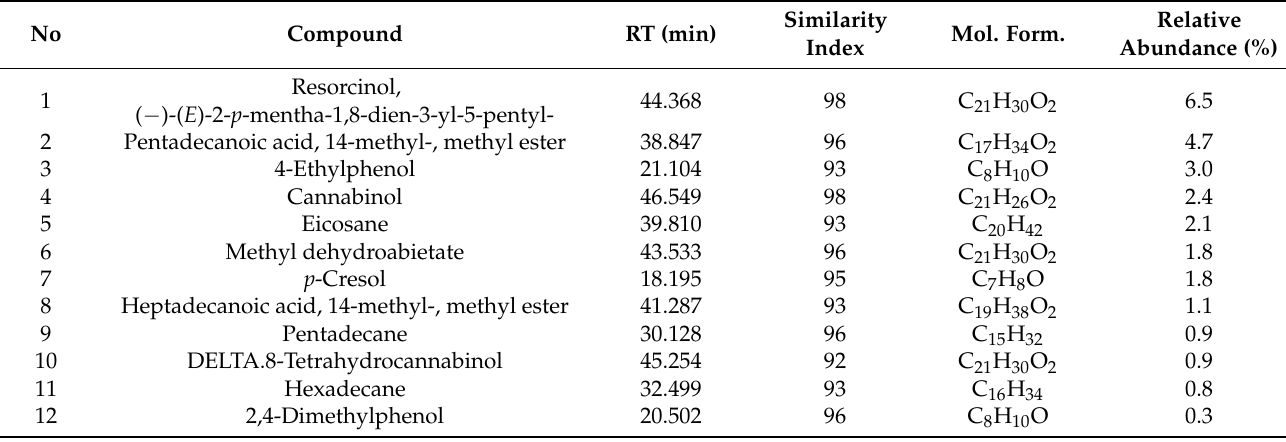
Table 4. Chemical composition of distillates of hemp leaves (LV1) from pyrolysis stage (PS) condensed at 130 ◦ C and analyzed by gas chromatography–mass spectrometry (GC-MS).